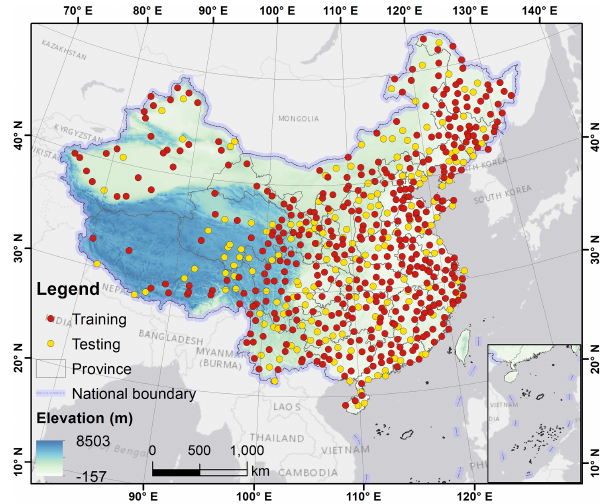
Figure 1. Elevation and spatial distribution of meteorological sta- tions across China (70% were used for training and 30% were used for